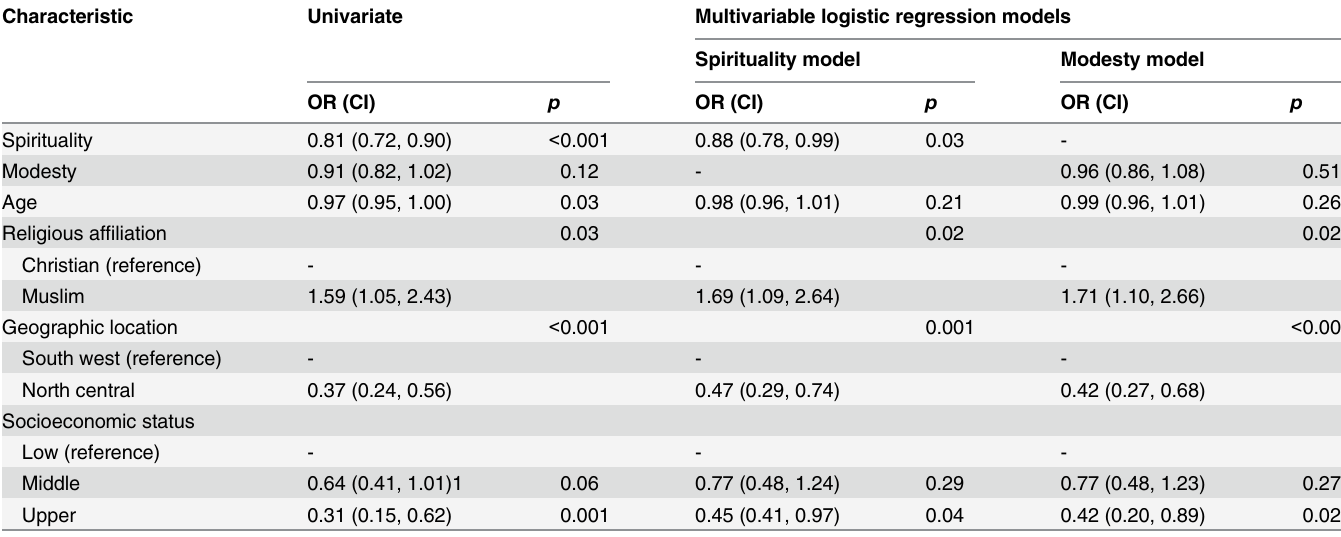
Table 3. Association between spirituality and modesty, and preference for self-sampling: age adjusted and multivariable logistic regression mod- els, Nigeria, 2014.